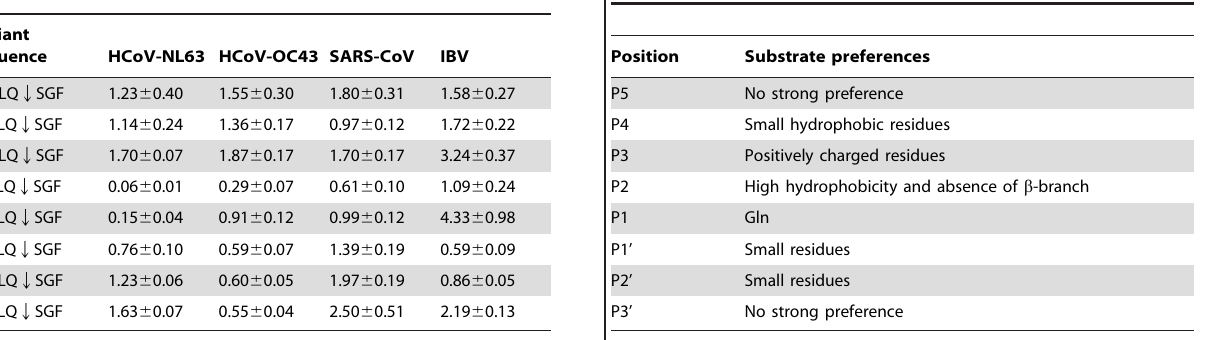
Table 1. 3CL pro activities against doubly- and triply- substituted substrate variants. WT substrate was substituted at P3 to P5 positions to generate doubly- and triply- substituted variants. The relative activities of 3CL pro on these substrate variants are reported. Table 2. Summary of substrate specificities that are common